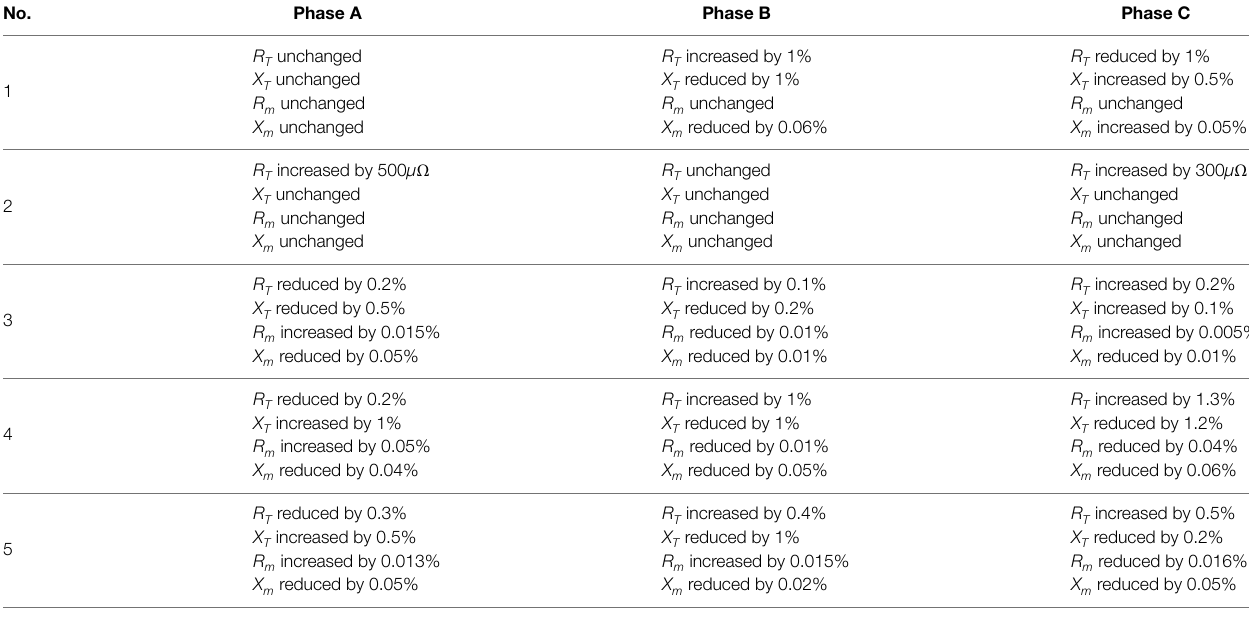
TABLE 7 | Variation of parameters due to transformer defects.